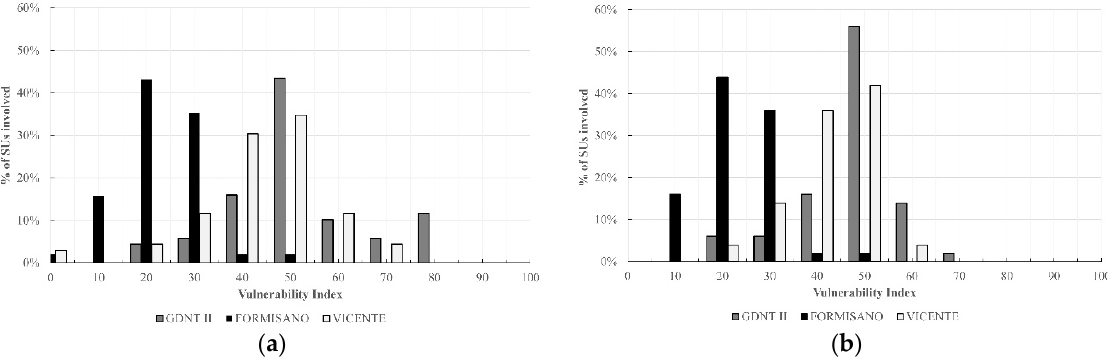
Figure 11. ( a ) Distribution of the I V through the different methods for 67 SUs; ( b ) distribution of the I V through the different methods for 50 SUs in the aggregate.